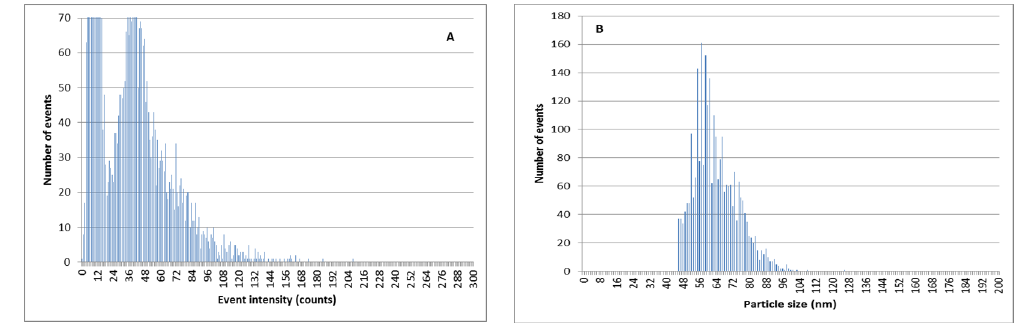
Figure 11. SP-ICPMS histograms of a mixture of Ag + and citrate-stabilized AgNPs of 60 nm 5:1 after double extraction procedure with 50 mg resin. ( A ) Signal distribution. ( B ) Particle size distribution. Table 3. Particle size of the AgNPs determined by SP-ICPMS in a mixture of Ag + :AgNPs 5:1 before and after a double extraction with Dowex 50W-X8 cation-exchange resin.